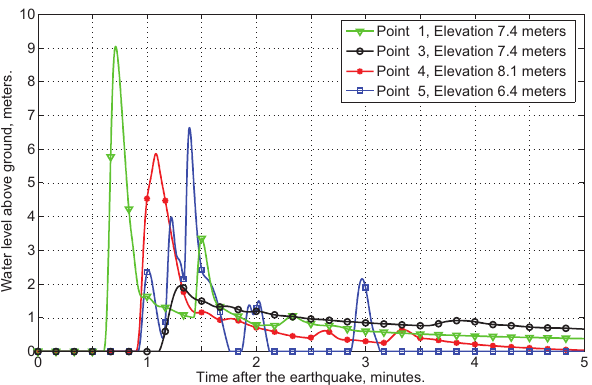
Fig. 11. Landslide-generated wave level above ground at certain locations near the Whittier water front. Location of Points 1, 3, 4 and 5 are shown in Fig. 2. The elevation of each point is with respect to the pre-earthquake sea level that was 0.3m above the MLLW. The difference between the MSL and MLLW is approximately